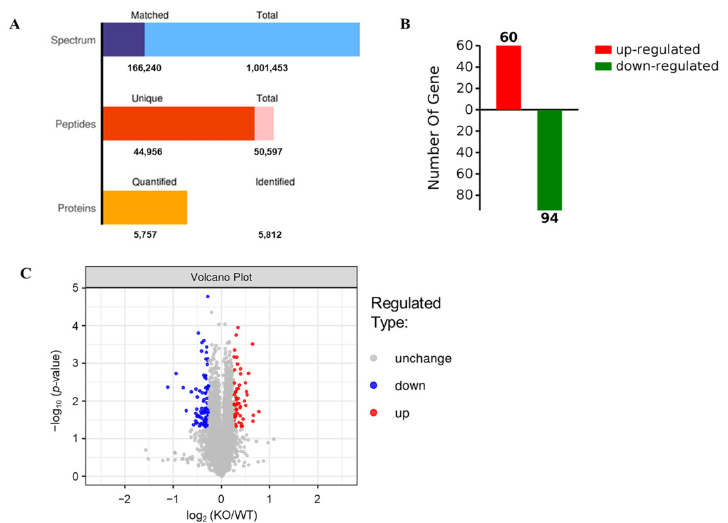
Figure 4. Differential expression of proteins detected by TMT in the livers of Selenot -KO and WT mice. ( A ) Numbers of spectrum, peptides and proteins. Total spectrum: the total number of secondary spectrograms; Matched spectrum: the total number of spectra matched the database. ( B ) Numbers of significantly up-regulated or down-regulated proteins in the livers of KO mice in comparison to WT mice. A protein was identified as significantly changed protein in the liver of KO mice if the FC was >1.2 (down < 0.83 times or up > 1.2 times), and the p -value was <0.05 compared with WT mice. ( C ) The volcano plots (log 2 (KO/WT) vs. − log 10 ( p -value)).